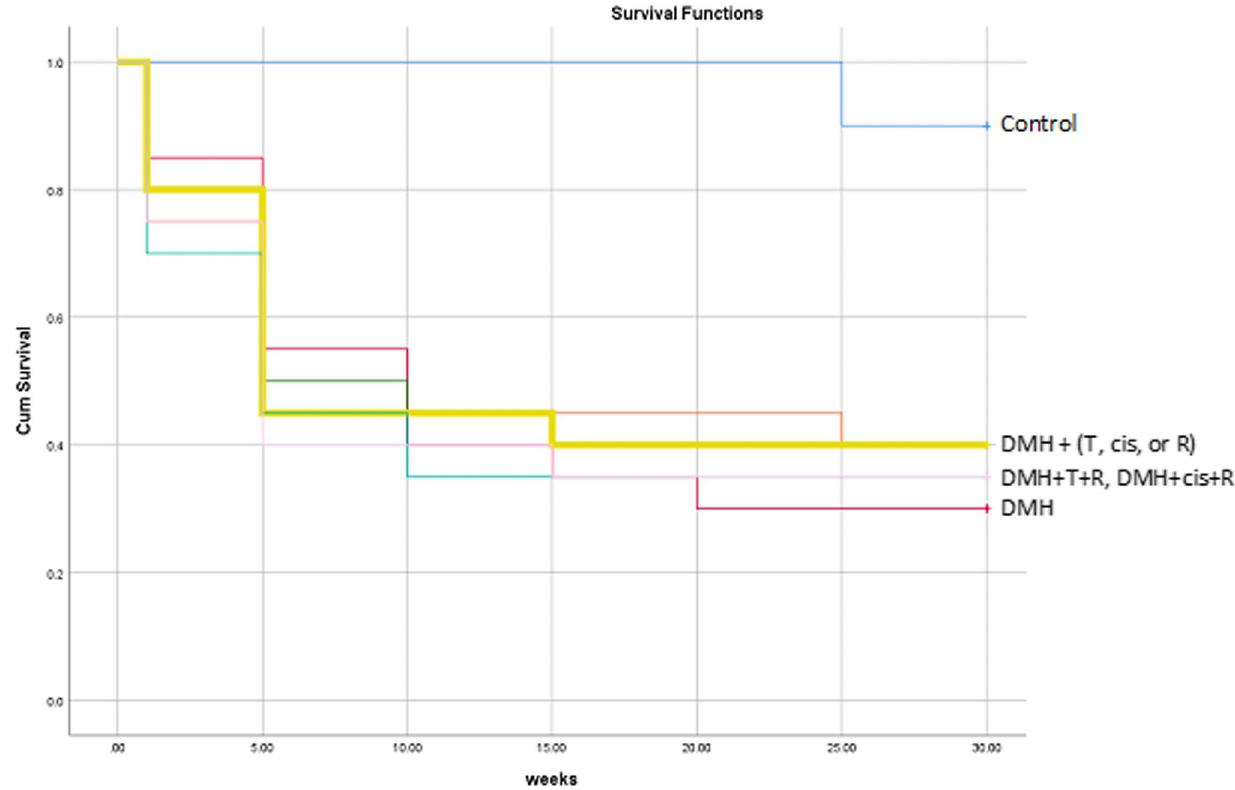
Table 2 Effect of thiophene derivative and radiation on the mortality rate, and tumor incidence, multiplicity, and count